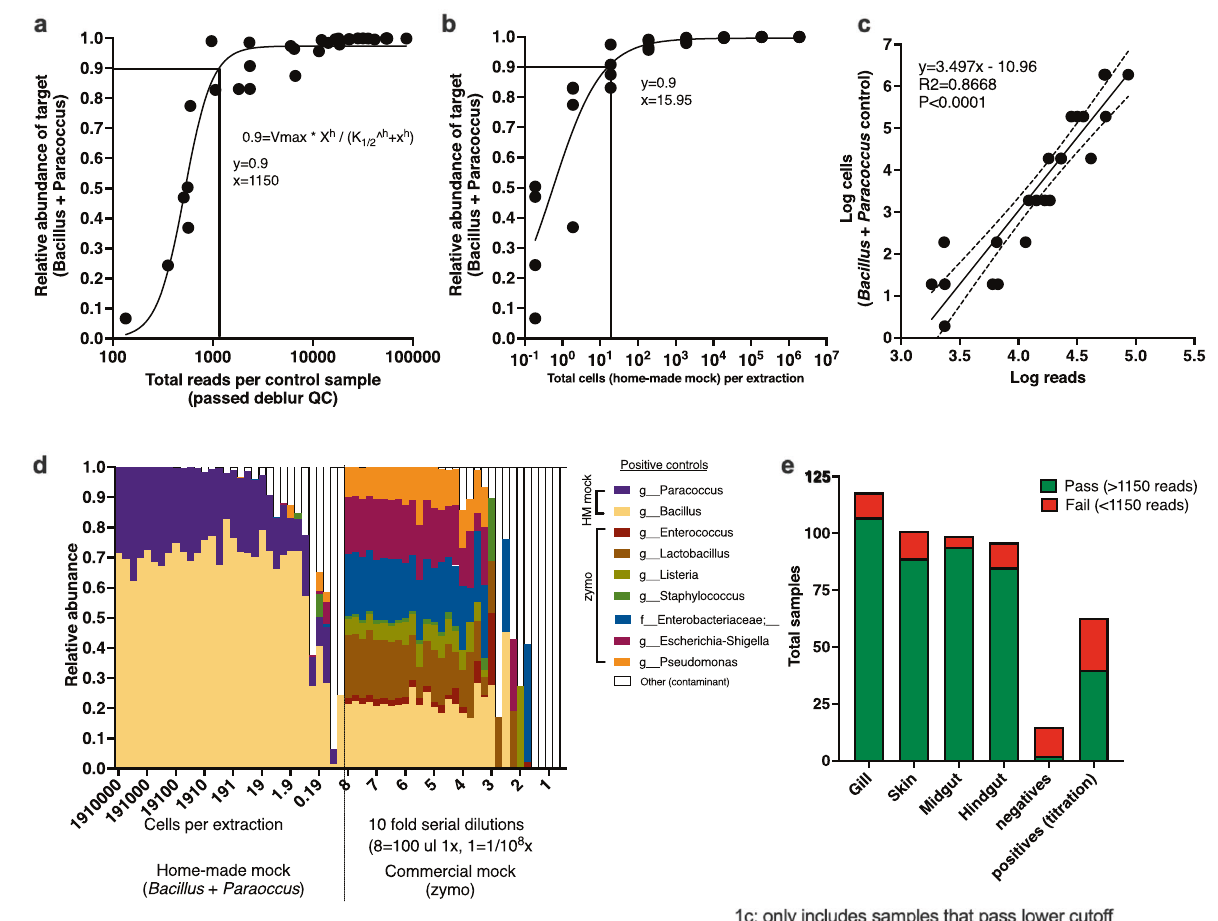
Fig.2|Limitofdetection,sampleexclusion,andmicrobialbiomassestimation for FMP101 dataset. a Application of KatharoSeq formula to calculate limit of detectionofmicrobiotaplatesusingtheBacillus/Paracoccusmockcommunity (1150 reads at 90%). b Limit of detection based on cell counts of Bacillus/ Paracoccus mock community (~16 cells into extraction at 90%). c Model fi t